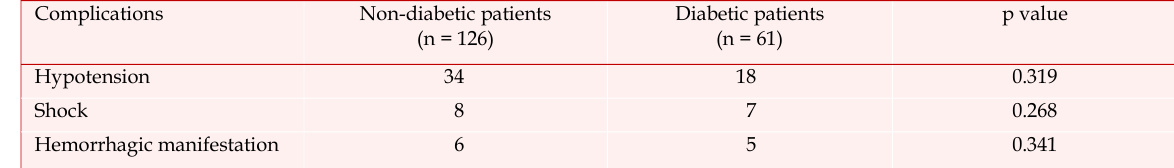
Streptokinase infusion related complications in non-diabetic and diabetic